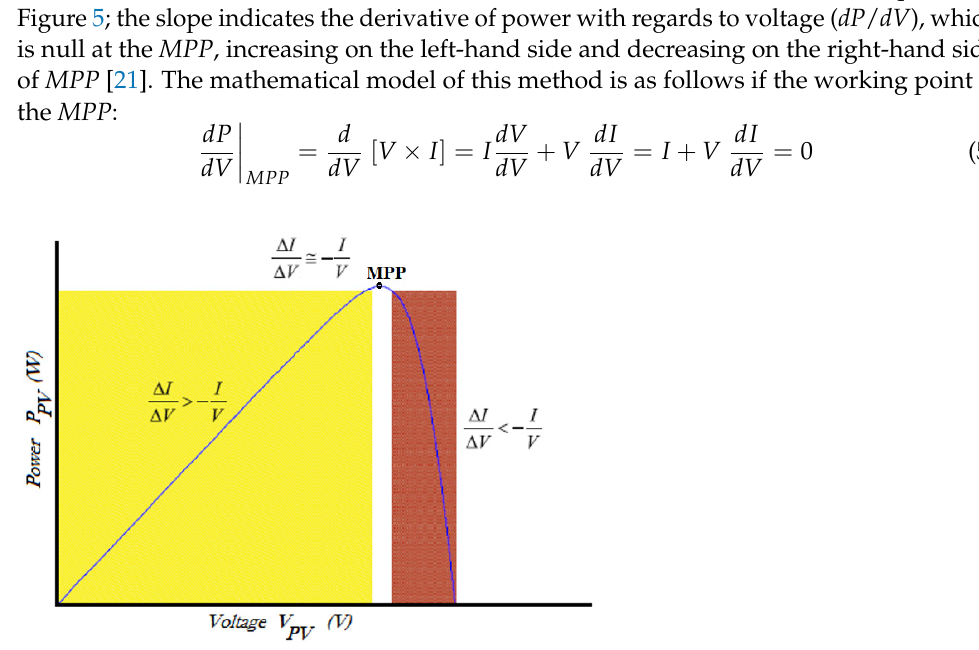
Figure 5. PV curve for the basic incremental conductance of MPPT.